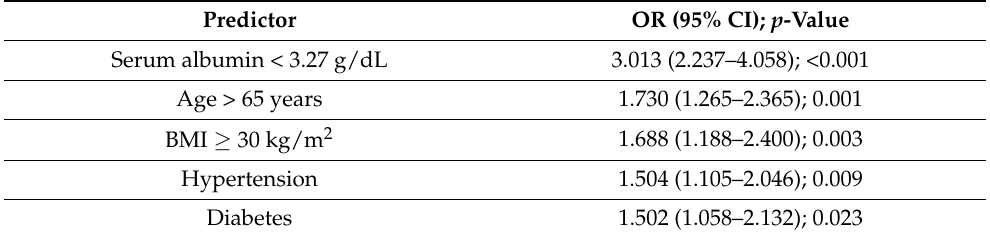
Table 3. Multiple linear regression analysis on independent predictors of hospital length of